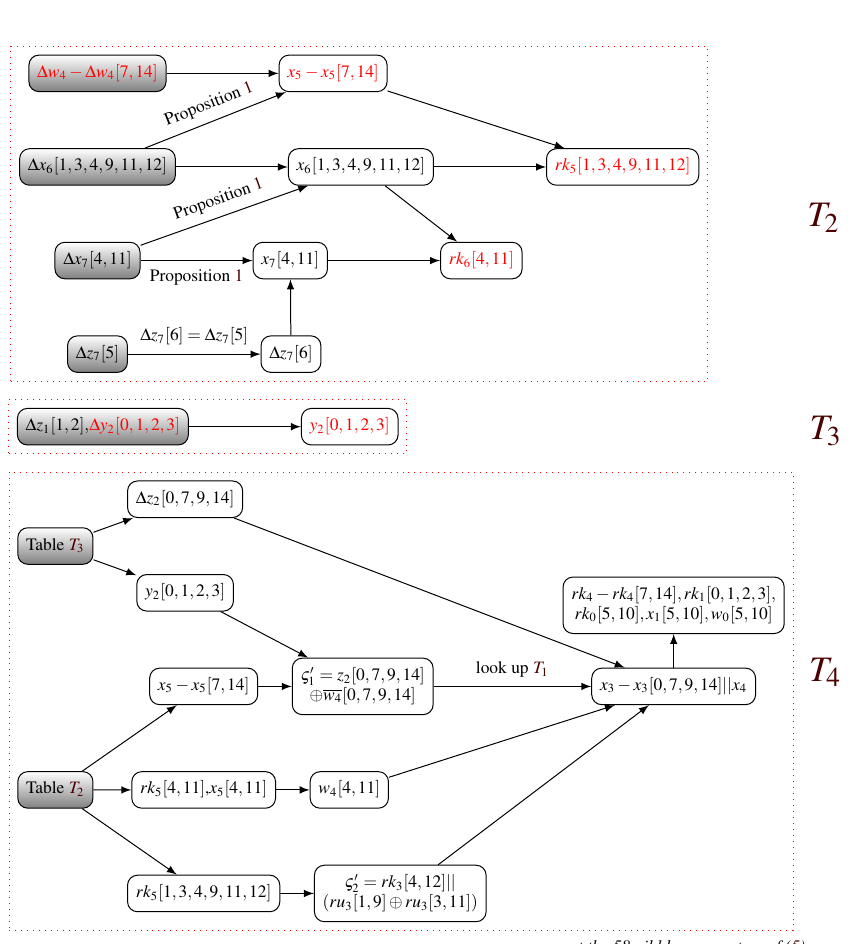
Figure 18: Constructions of Table T 2 , Table T 3 and Table T 4 on the 12-round